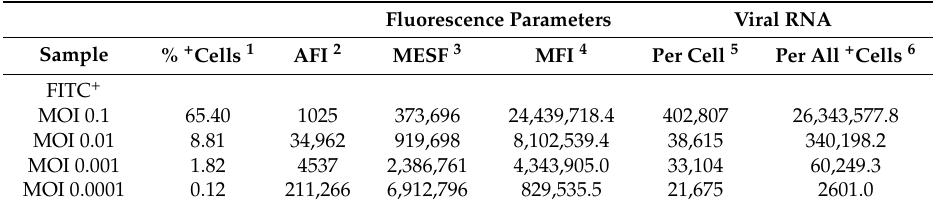
Table 1. Preliminary assays to evaluate the performance of the method for discrimination between different virus concentrations.